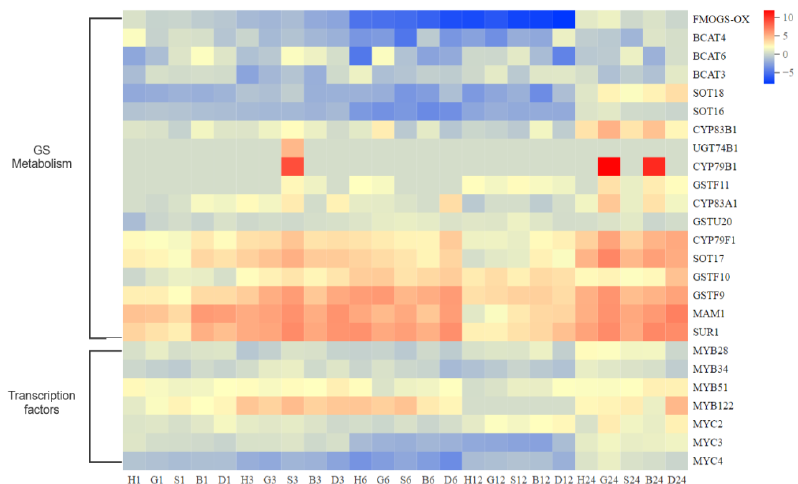
Figure 10. DEGs of metabolism, resistance, and growth response to spraying treatments at 1, 3, 6, 12, and 24 h. Heat map represents the value of DEGs as L2FC relative to CK (0 h) (H, H 2 O treatment; G, GSH treatment; S, GSSG treatment; B, BSO treatment; D, DTT treatment).